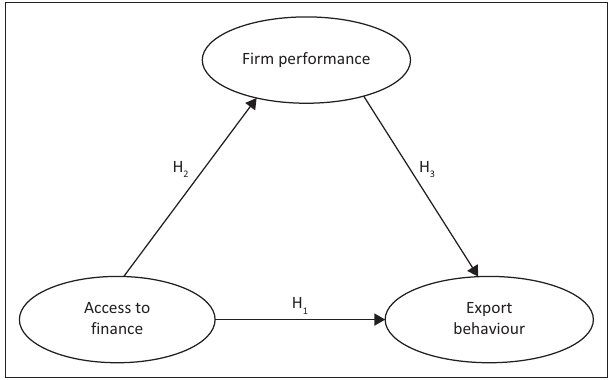
FIGURE 1: Conceptual